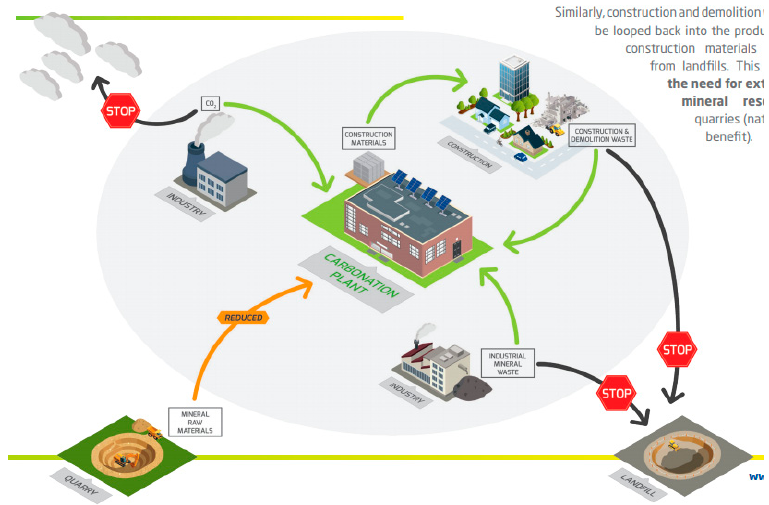
Figure 12. CO2 Capture and Mineralisation Schematic Diagram. Figure 12. CO 2 Capture and Mineralisation Schematic